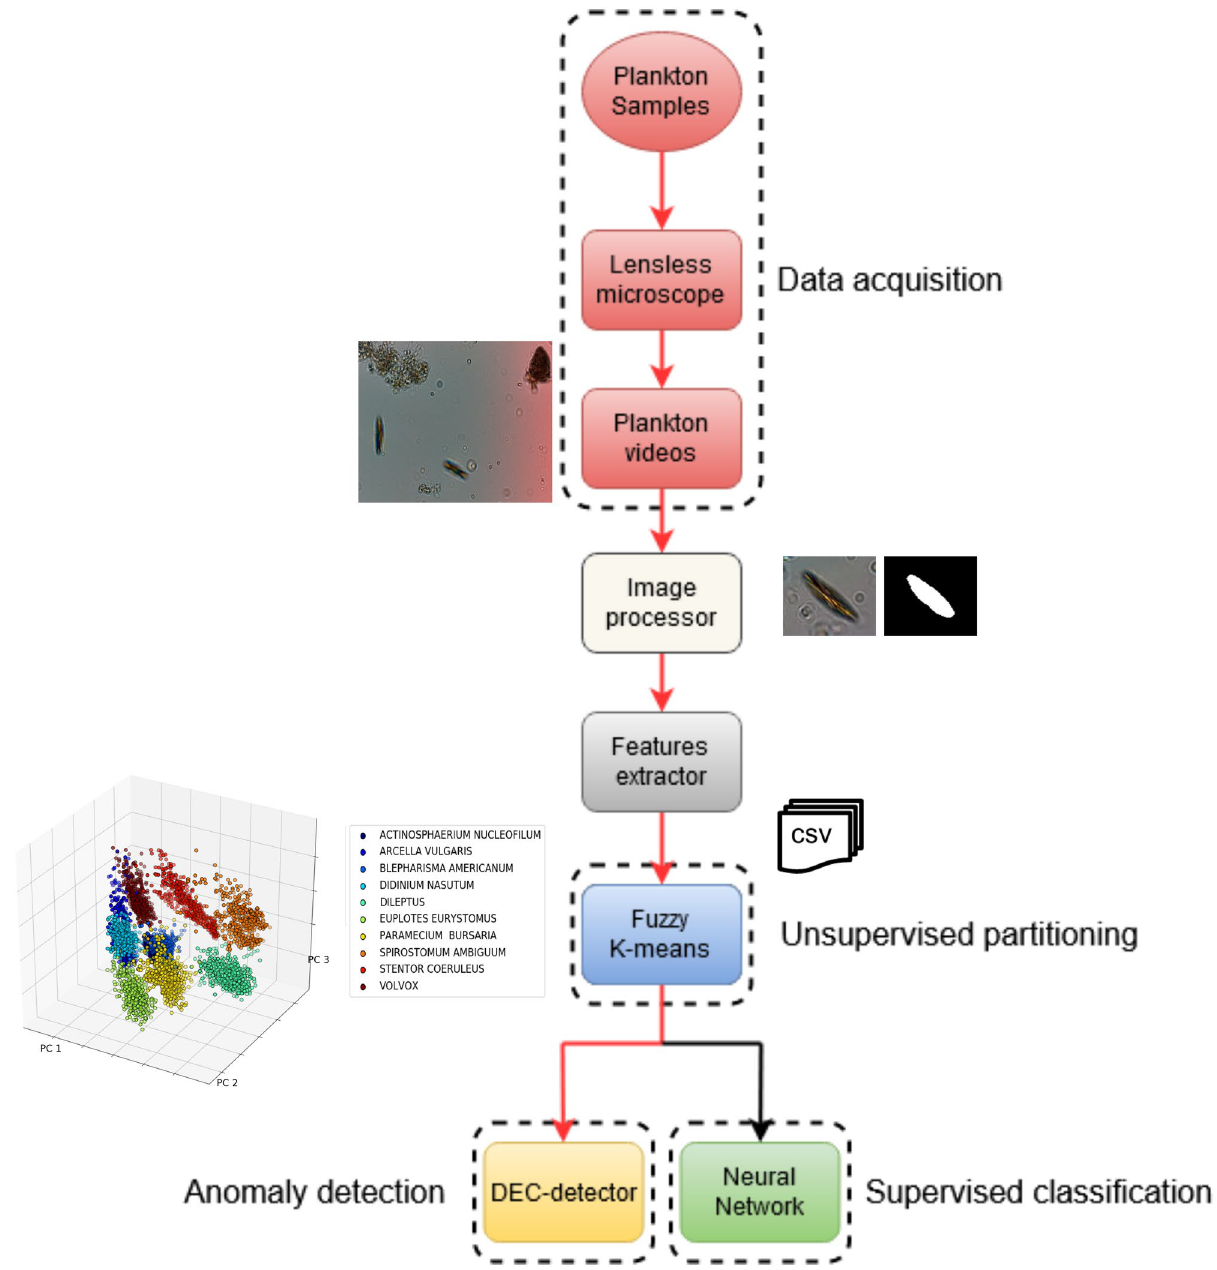
Figure 1. Schematic overview of the pipeline used to detect and classify plankton species with minimal supervision. Our preferred embodiment is represented by the red